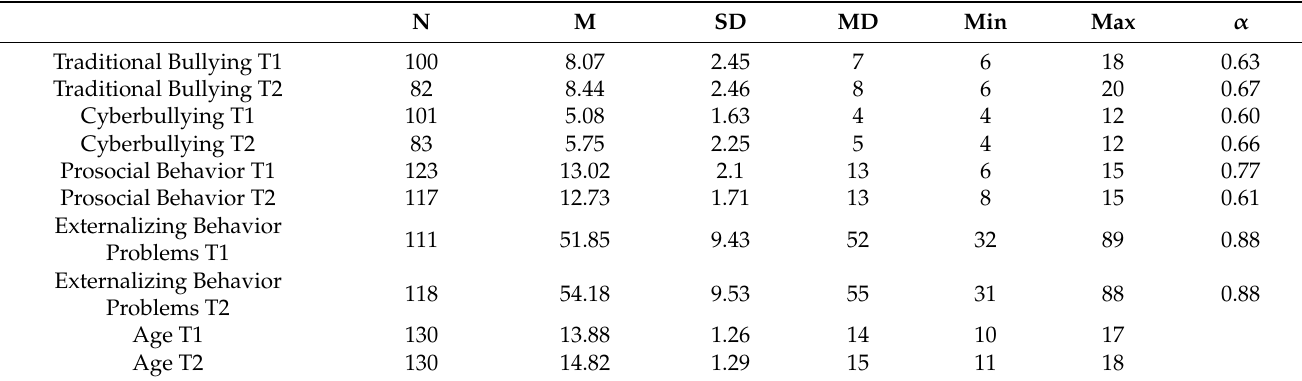
Table 1. Descriptive statistics for all study